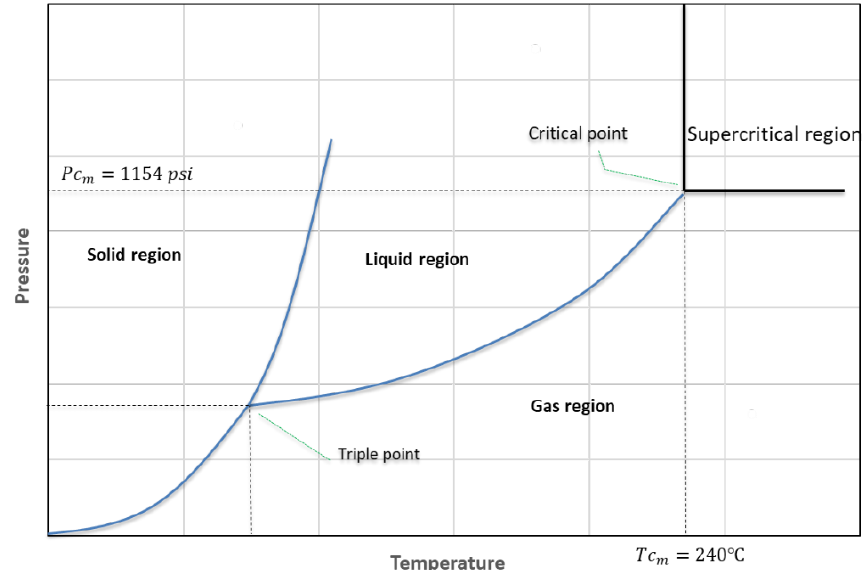
Figure 3. Methanol supercritical point.